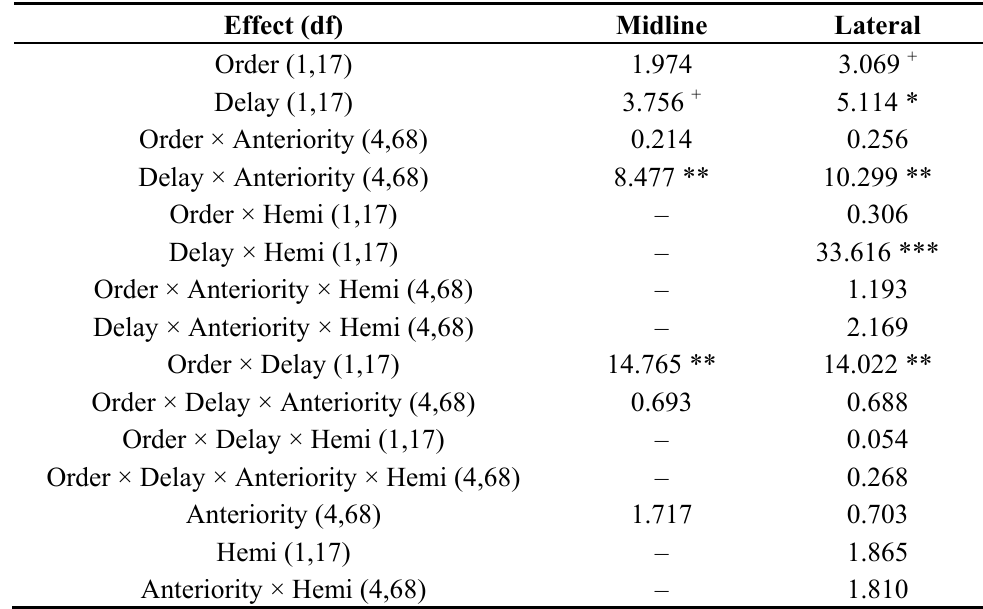
Table 6. Results from ANOVA ( F -values) on the mean amplitudes in the 180–280-ms interval from the onset of the post-delay letter (680–780 ms and 980–1080 ms from the preceding letter in the no delay and delay conditions,